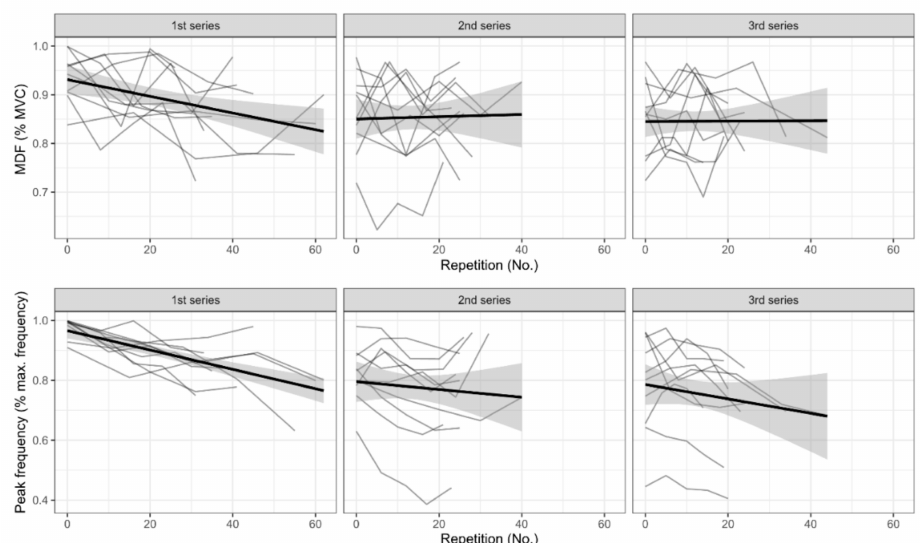
Figure 3. Neuromuscular activation responses during exercise during the three series. A linear trend line with a 95% credibility interval (CI) has been added to each series plot. MDF is the median frequency and MVC is the maximum voluntary contraction.